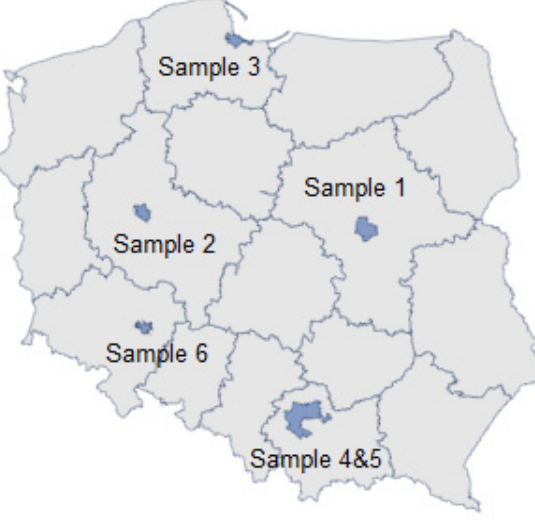
Figure 1. Sampling location map .